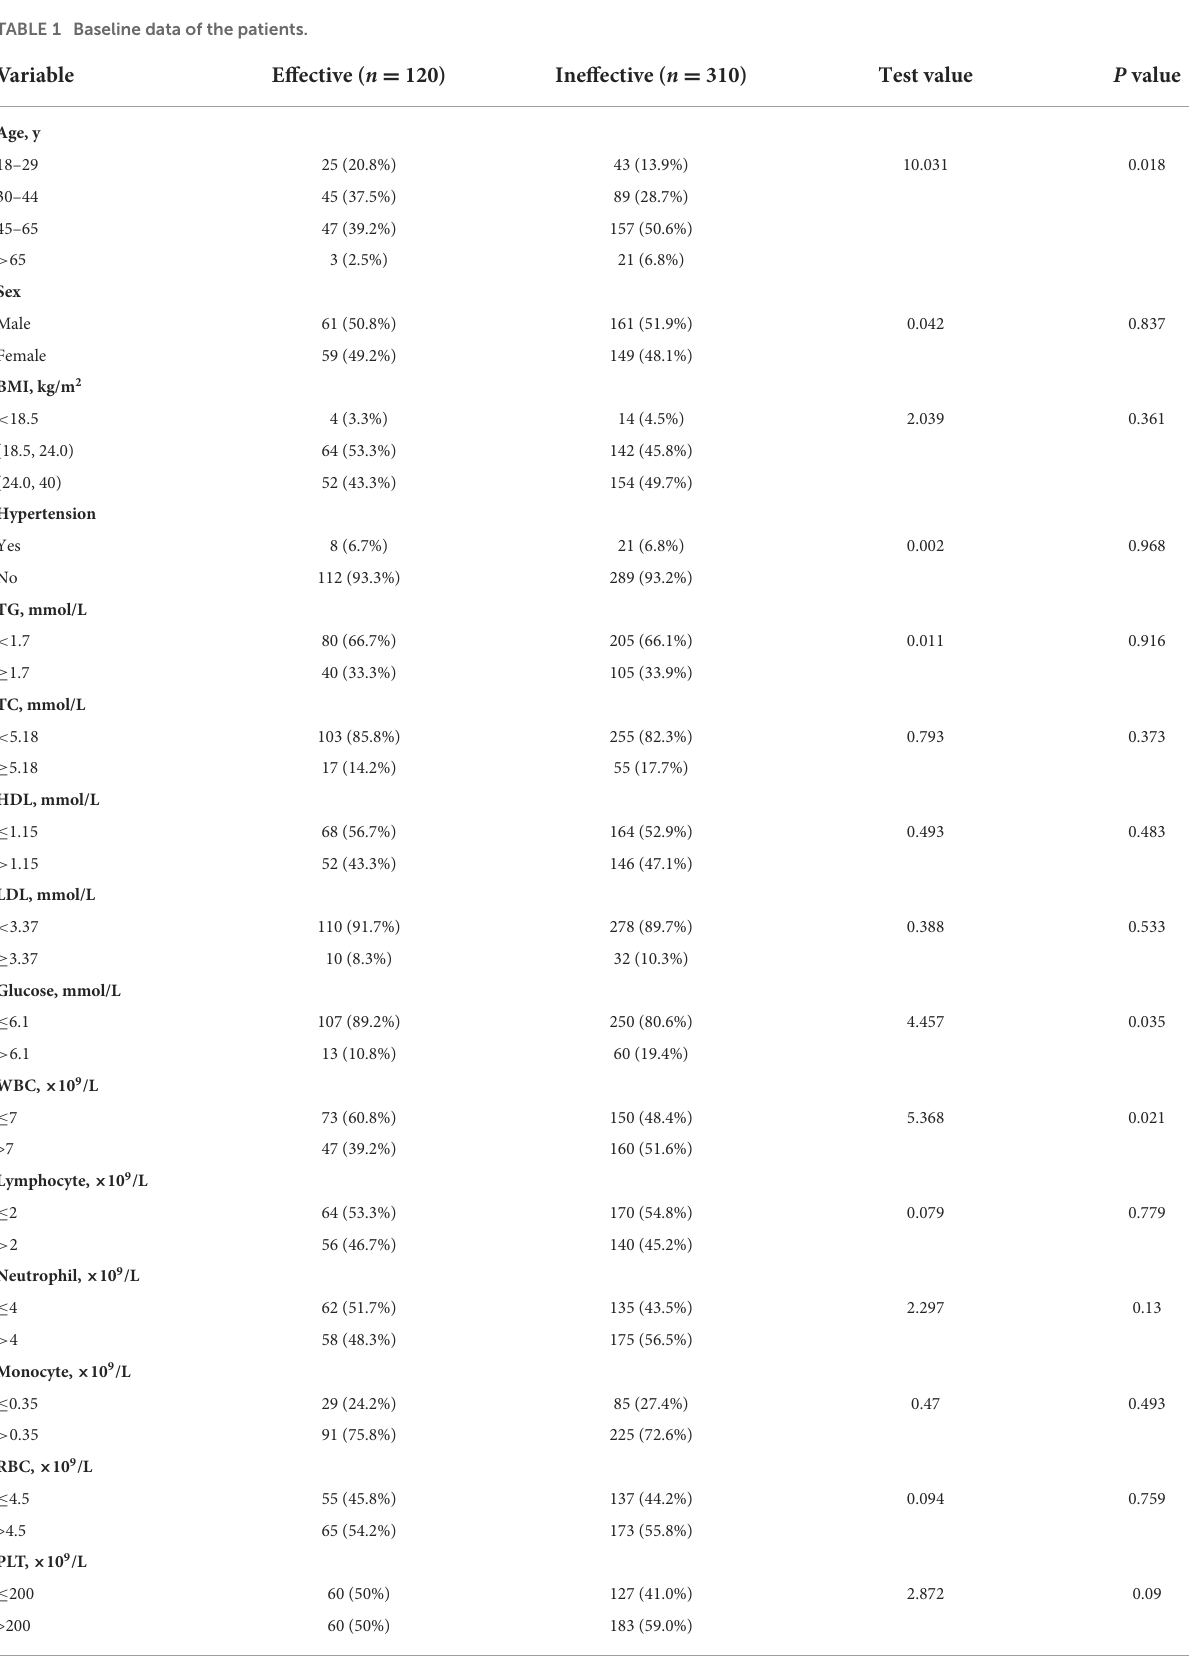
TABLE 1 Baseline data of the